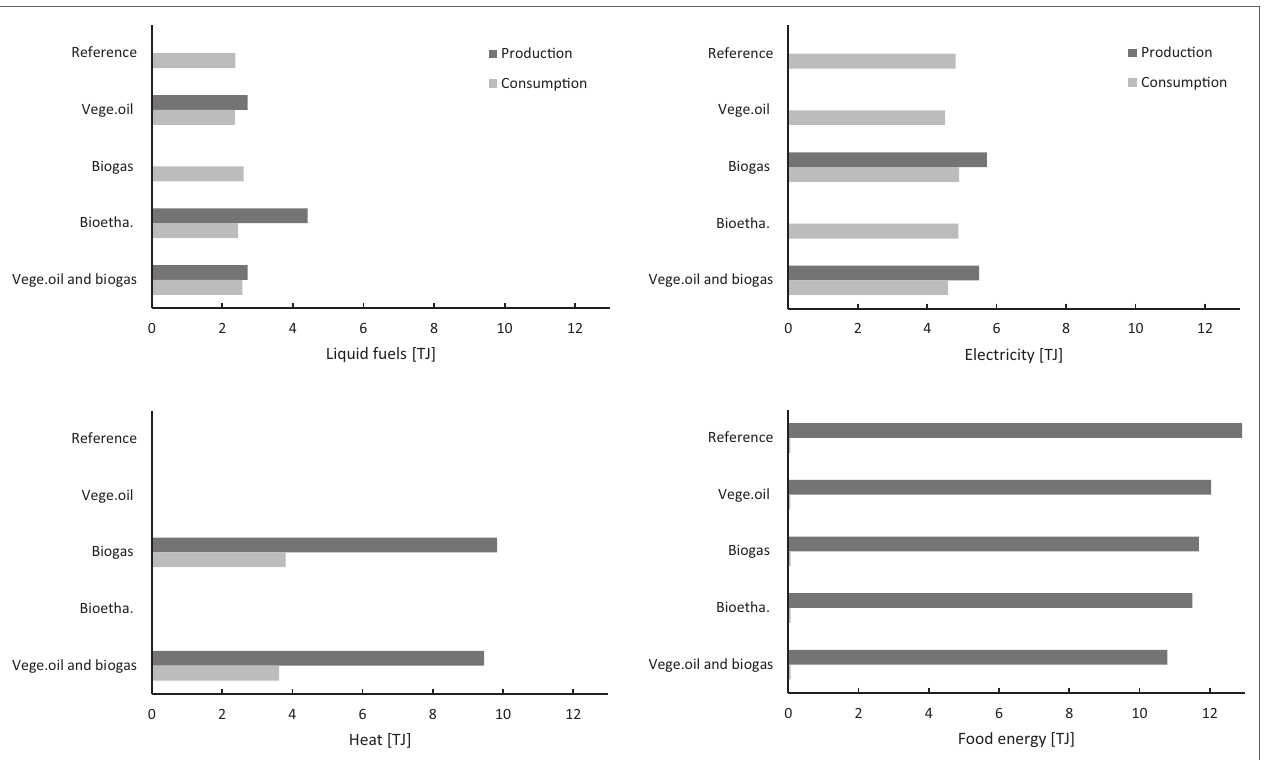
production ( Table 2 ). farm concluded that allocating 9.3, 5.9, and 3.8% of farm land to oilseed rape for biodiesel, winter wheat for ethanol, and ley for biogas, respectively, would be sufficient to meet the on-farm fuel demand (Fredriksson et al., 2006). The energetic values of our results are essentially in agreement with these results. However, in our study, we do not consider the possibility of using biogas as a motor fuel or using ethanol to substitute diesel or to be produced on small scale suitable for a farm community (see Technologies for Producing Bioenergy in Organic